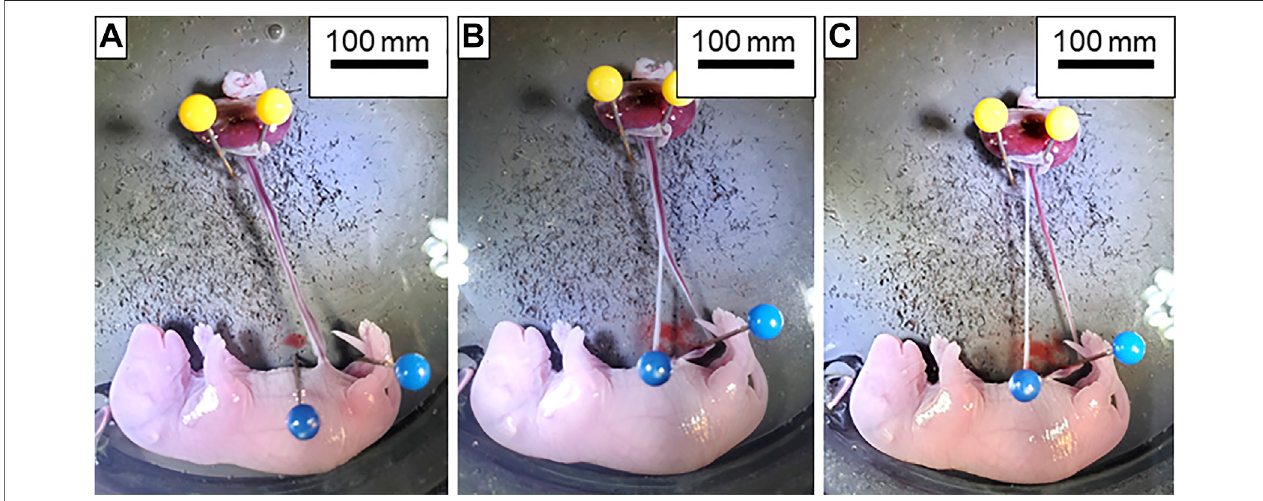
FIGURE 1 | Dissection of the umbilical artery and vein. (A) Isolated fetoplacental unit with the umbilical artery and vein completely intact. (B) Dissection of the umbilical artery (white vessel located on the left) and vein (red vessel on the right) beginning at the insertion into the fetus. (C) Umbilical artery and vein completely separated from fetus to the placenta and ready for transfer to the chamber.